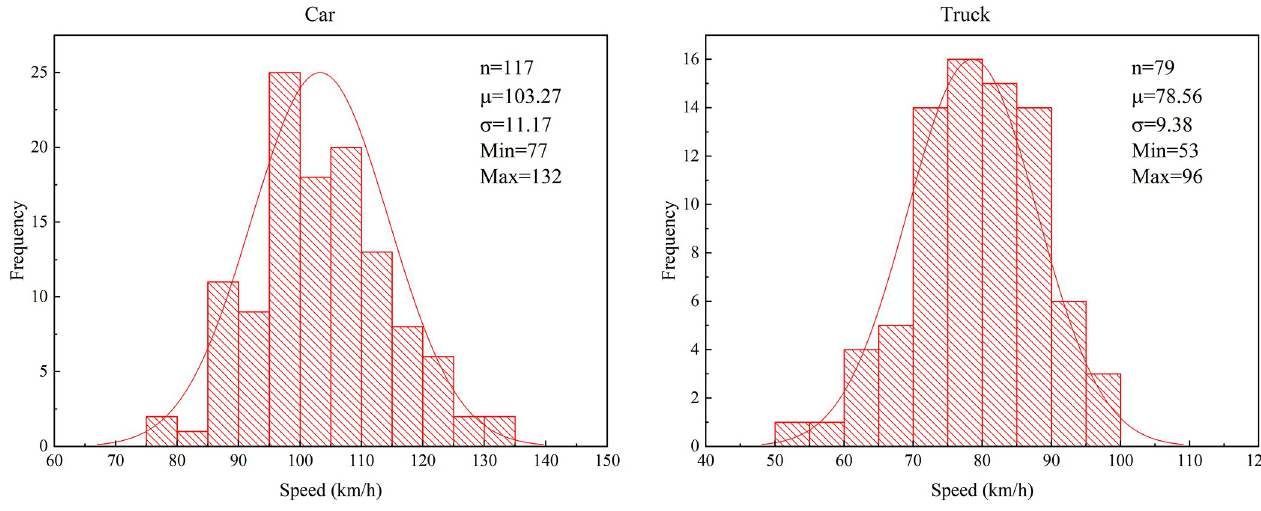
Fig 4. Speed information: (a) Car, (b) Truck.